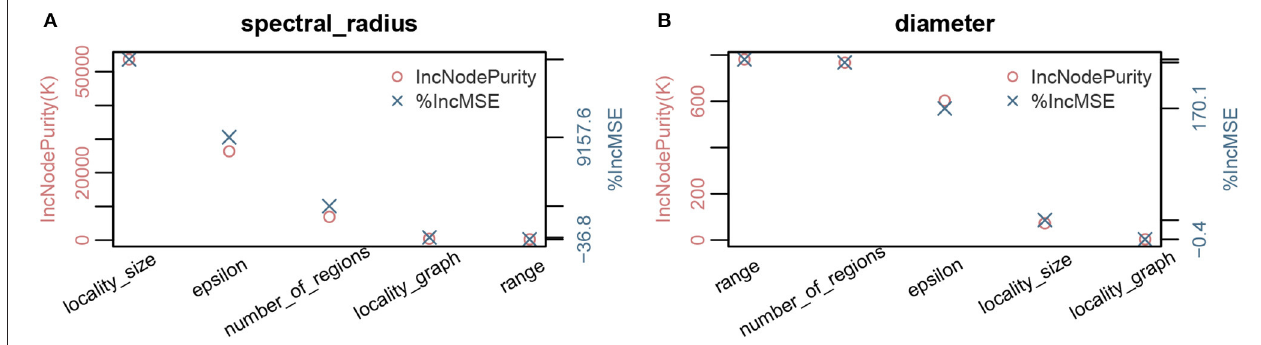
c < 1. All pathway parameters α s , α ℓ , and α ℓ d are either set to 0 or c . In the experiments, we ≤ c , α ℓ 0, α ℓ d 0), followed by intra-locality edges ( α s = = = 0, the variance is higher compared to the remaining cases as these also account for 10 6=